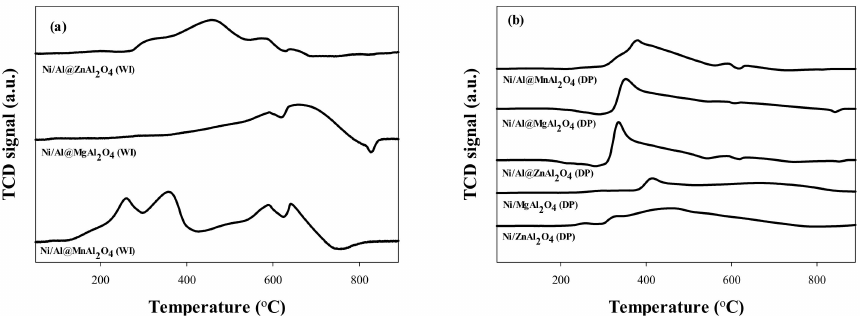
Figure 3. Temperature-programmed reduction with H 2 (H 2 -TPR) profiles for supported Ni catalysts, prepared by ( a ) the WI method and ( b ) the DP method.